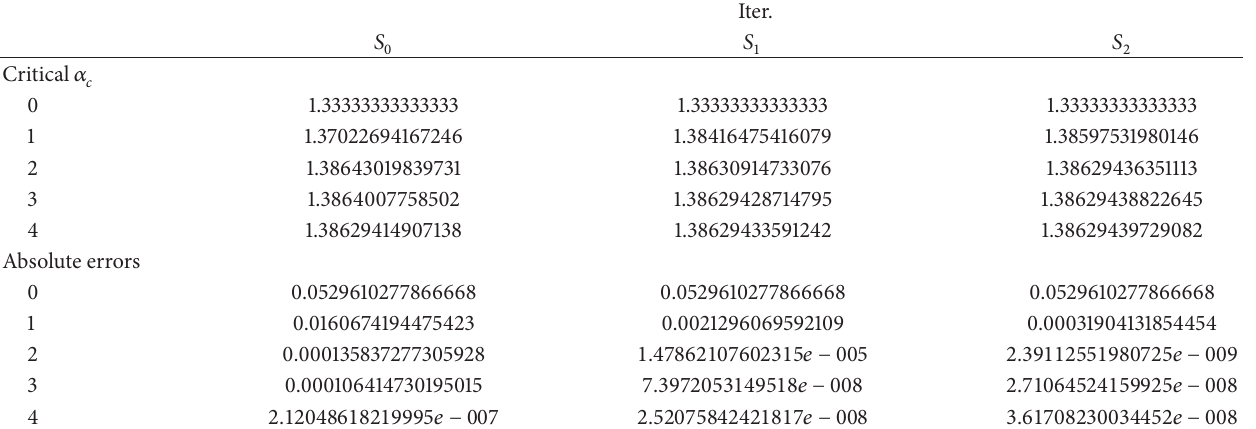
Table 6: Iterative convergence for different schemes for the critical value of 𝛼 𝑐 for Frank problem, 𝑁 = 200 .